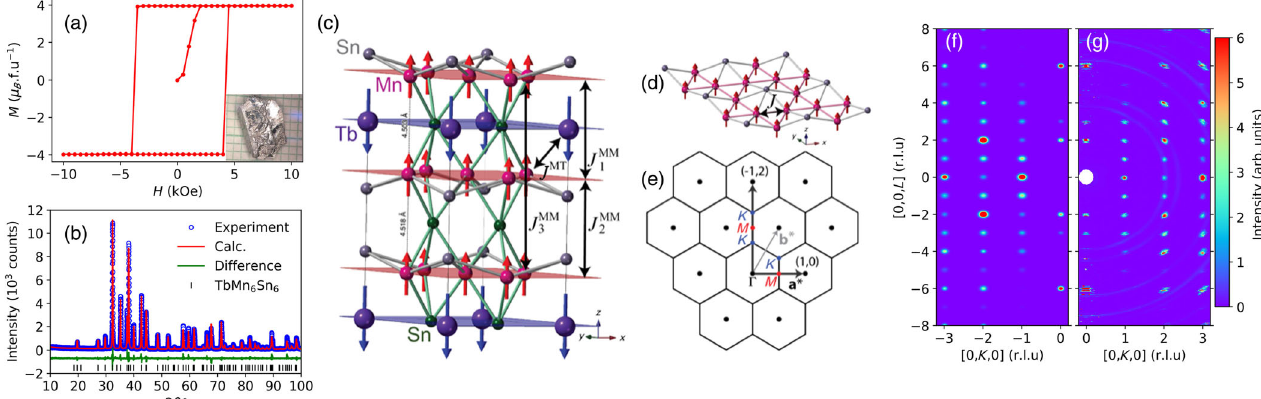
FIG. 1. (a) Single-crystal magnetization data for Tb166 recorded at 2 K with H applied along c . The inset shows a typical single- crystal sample of Tb166. (b) Powder x-ray diffraction measurements of Tb166 collected at room temperature and fitted using Rietveld refinement analysis. (c) Ferrimagnetic ground state structure of TbMn 6 Sn 6 . Key interlayer interactions are shown with heavy black arrows. (d) Magnetic interactions within a single Mn-Sn kagome layer. (e) 2D hexagonal Brillouin zone showing conventional reciprocal lattice vectors a (cid:3) and b (cid:3) and special points, Γ (black), K (blue), and M (red). Inelastic neutron scattering data are discussed in terms of the orthogonal vectors (1,0) and ð − 1 ; 2 Þ . (f) Simulated ð 0 ; K; L Þ elastic single-crystal neutron scattering intensity containing both nuclear and magnetic components for Tb166 below 250 K. The reciprocal space is here set in the conventional way. Antiparallel magnetic moments of 9.0 μ B (Tb) and 2.17 μ B (Mn) are set along c . (g) Tb166 elastic single-crystal neutron scattering data collected on ARCS in the (0, K , L ) scattering plane at 7